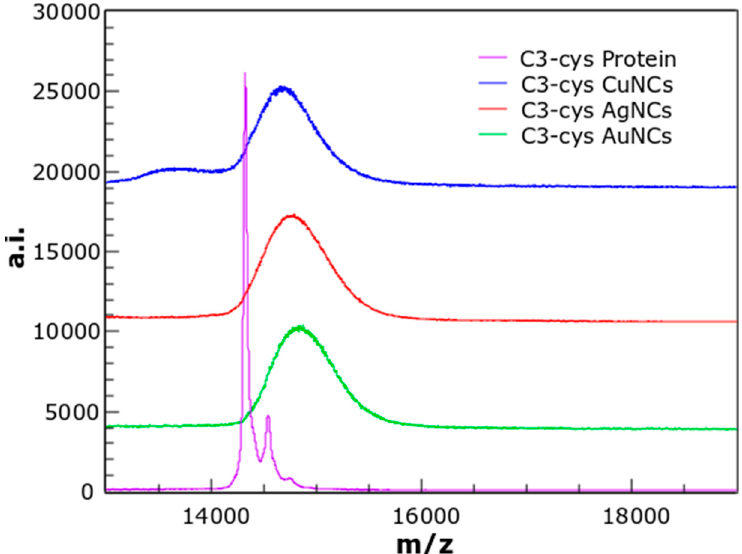
Figure 2. Mass spectra of non-conjugated C3_cys protein (magenta trace), and the protein-NCs conjugates: C3_cys-CuNCs (blue trace), C3_cys-AgNCs (red trace), and C3_cys-AuNCs (green trace). The shifts in the peaks relative to the protein spectrum correspond with the absorption of six Cu atoms, five Ag atoms, and three Au atoms.